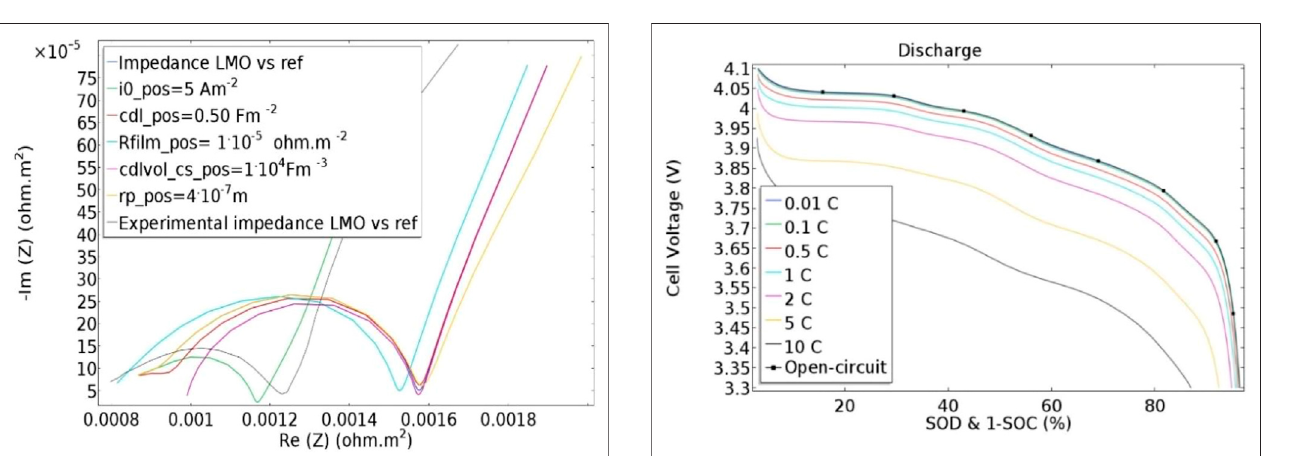
FIGURE 9 | Nyquist spectra for testing fi ve control parameters at 10 MHz to 1 kHz frequency.